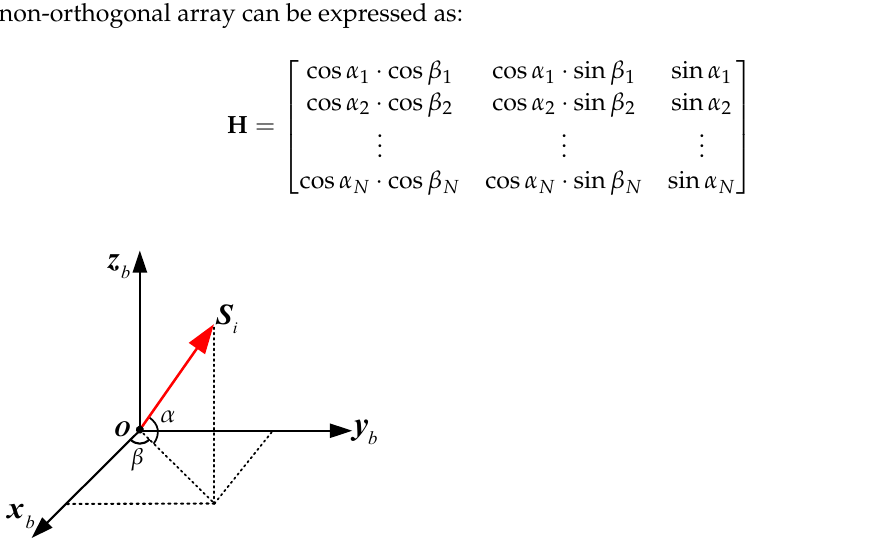
Figure 5. Installation schematic diagram of the component gyroscopes.